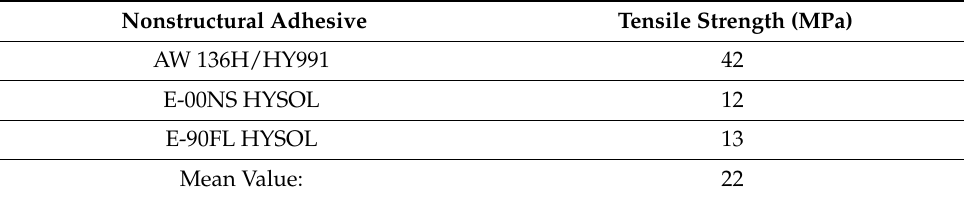
Table 12. Tensile strength of nonstructural adhesives.